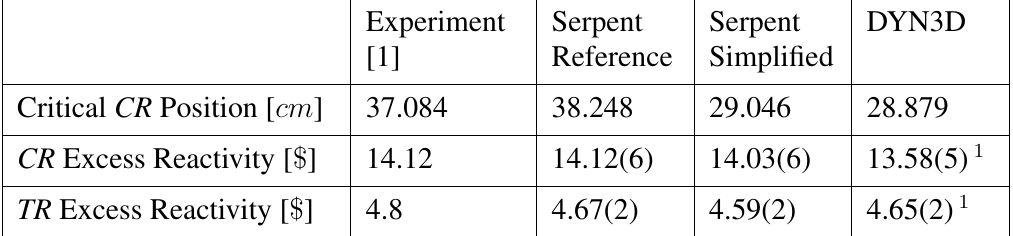
Table 1: Static core characteristics of the SPERT III E-core for Cold-Startup from Serpent and DYN3D calculations compared with experimental data.